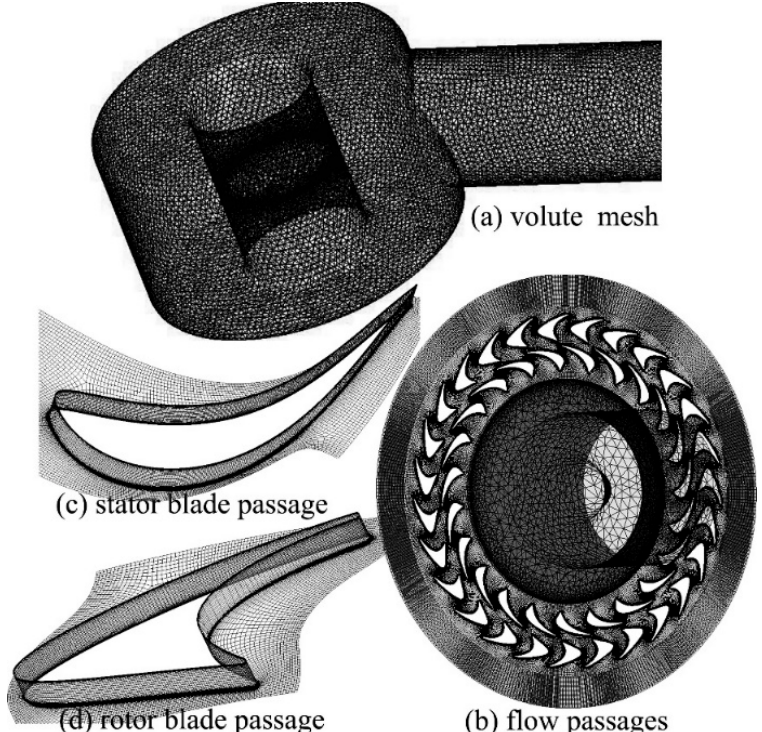
Figure 3. Computational grid.